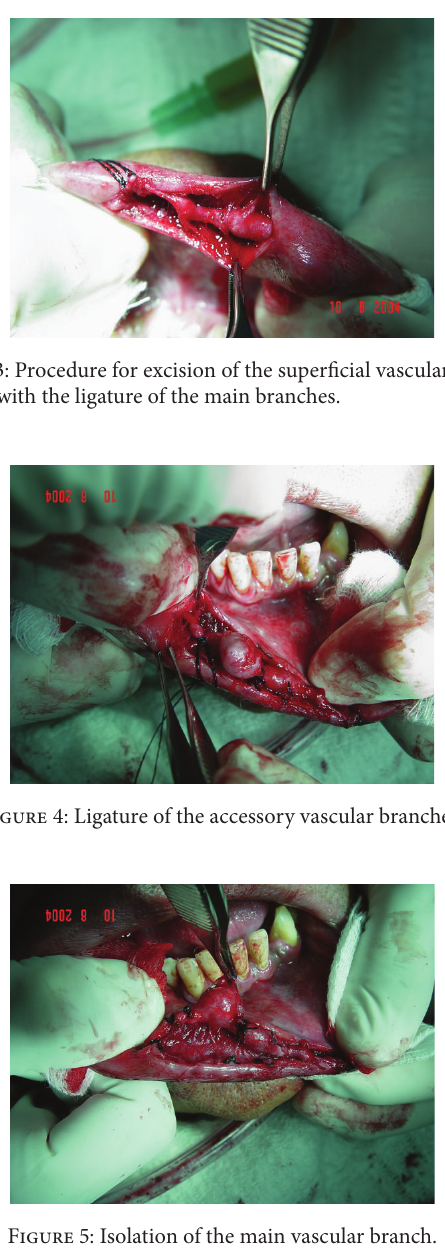
Figure 5: Isolation of the main vascular branch.